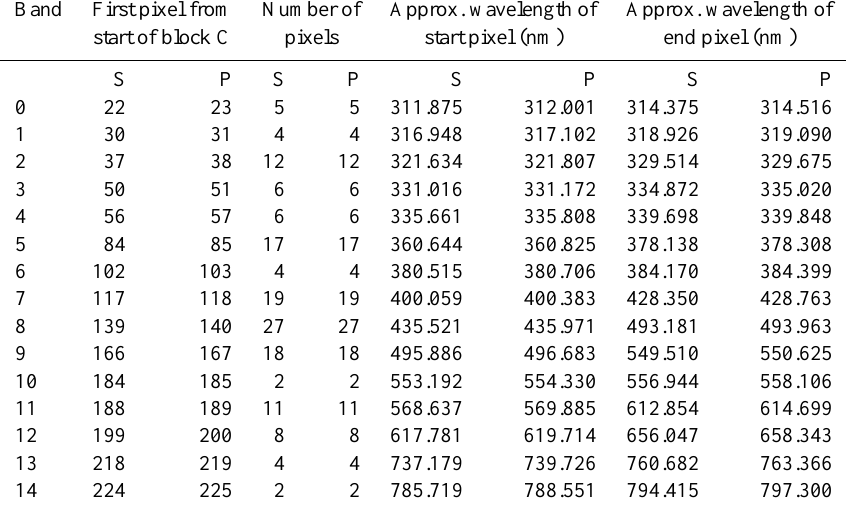
Table 6. GOME-2 Metop-B PMD band definitions (v2.0). This set is valid from 29 October 2012 during orbit 598. Here “P” indicates PMD-P which measures intensity polarized parallel to the spectrometer’s slit, and “S” indicates PMD-S which measures intensity polarized perpendicular to the spectrometer’s